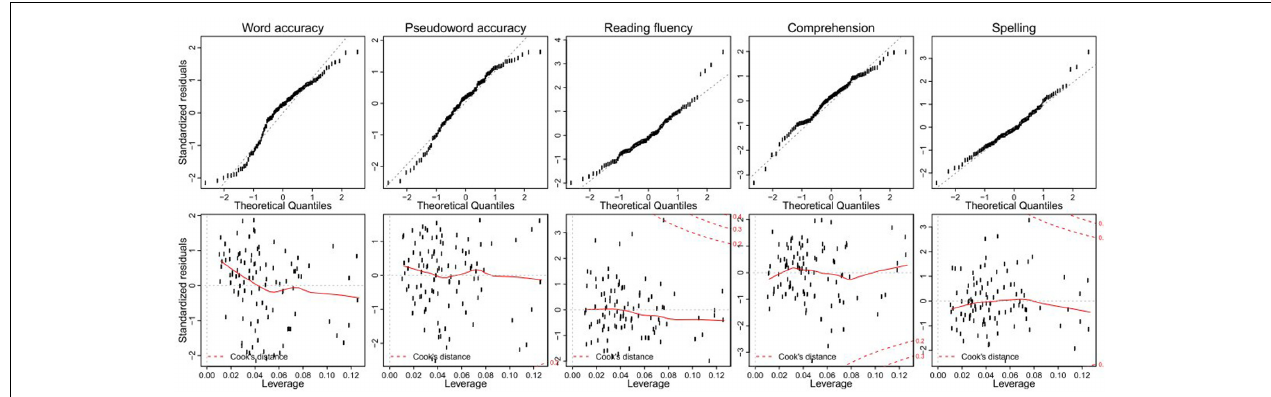
FIGURE 1 | Multiple regression diagnostics. (Top) Quantile–quantile plots of standardized residuals for the longitudinal prediction of each outcome variable. (Bottom) Corresponding leverage-residual plots with overlaid smooth trend, also displaying Cook’s distance curves at values of 0.2 and 0.3.